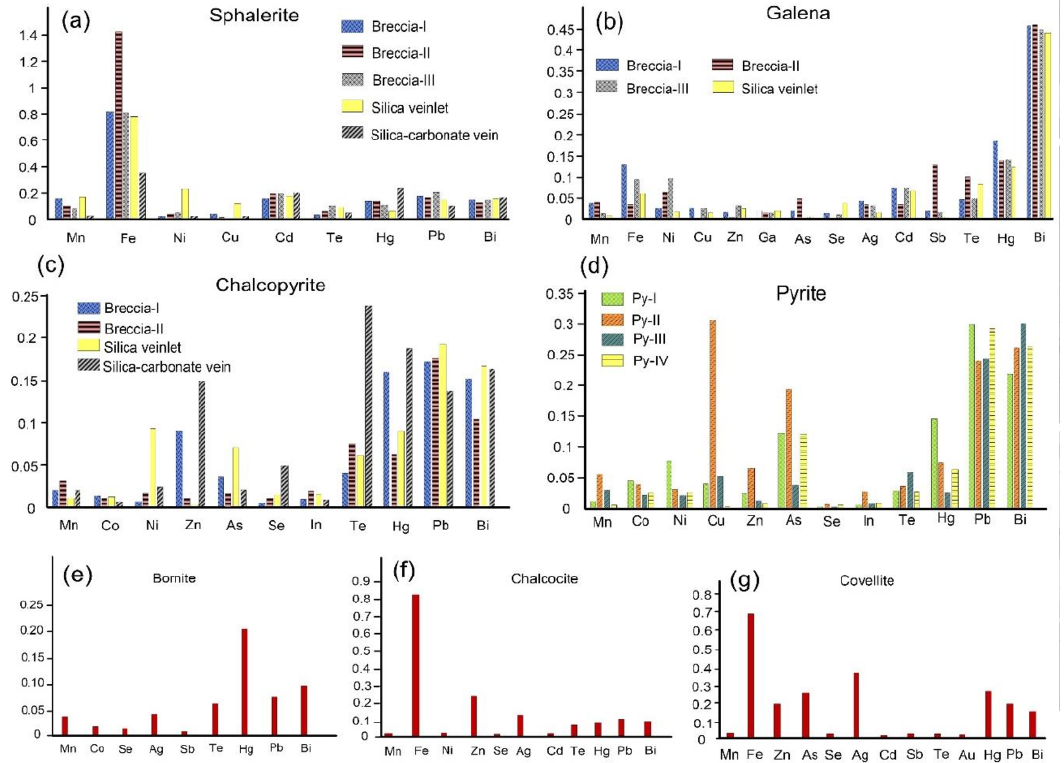
Figure 13. Histograms showing the average concentrations of the trace elements in different minerals of Shah-Ali-Beiglou deposit: ( a ) Sphalerite; ( b ) Galena; ( c ) Chalcopyrite; ( d ) Pyrite; ( e ) Bornite in Breccia-III and silica-sulfide veinlets; ( f ) Chalcocite in Breccia-III-veinlets; ( g ) Covellite in Breccia-I and silica-sulfide veinlets (ascribed of ore minerals is based on the texture features; data in wt